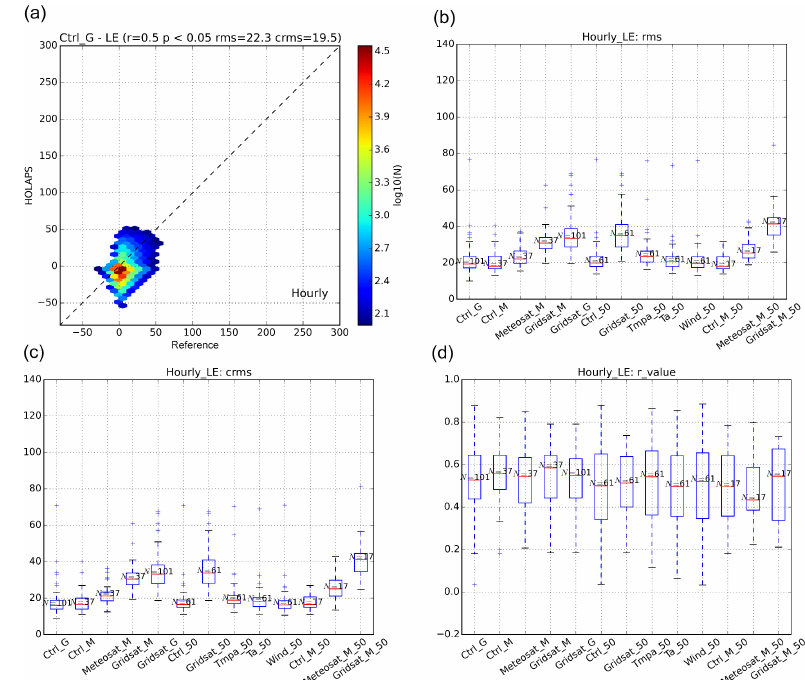
Figure E7. Error statistics for HOLAPS latent heat flux over cloudy-sky condition: (a) comparison using results from all stations and years, (b – d) box plots of validation statistics that are calculated at each